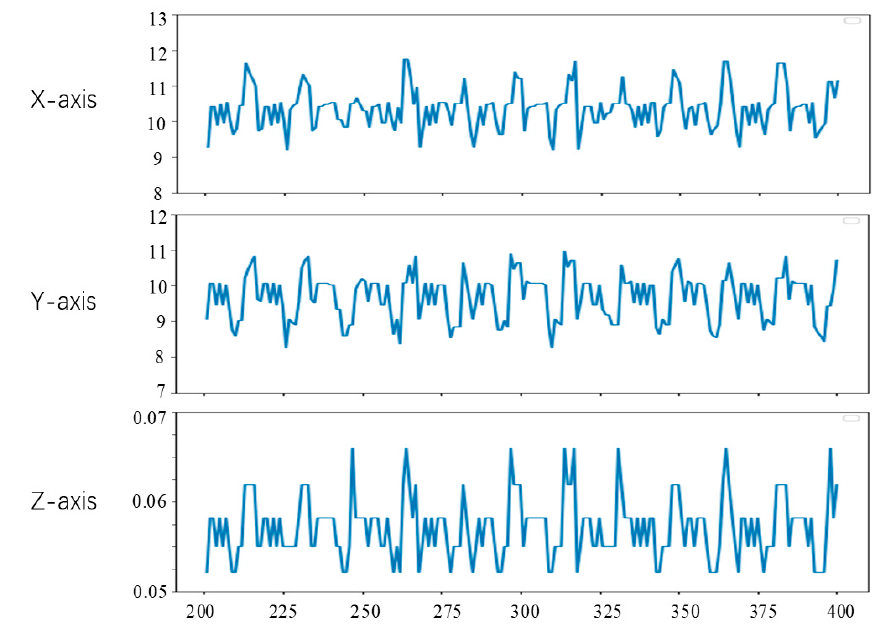
Figure 15. Point a motion tracking results.